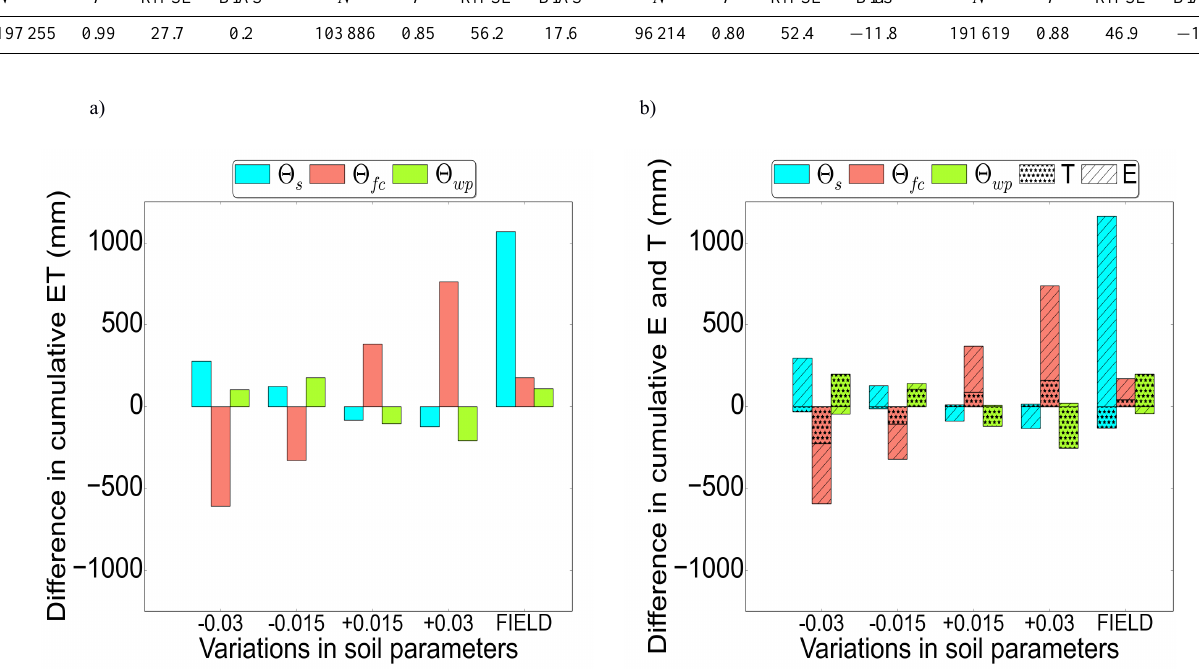
Figure 4. Sensitivity analysis: impact of variations in soil moisture at saturation ( θ s ), soil moisture at field capacity ( θ fc ) and soil moisture at wilting point ( θ wp ) on simulated (a) evapotranspiration (ET) and (b) soil evaporation ( E ) and plant transpiration ( T ), cumulated over the 12-year period. We display the difference in cumulative flux between the simulation PTF and the simulation PTF with modified soil parameters. FIELD means that the in situ values of the soil parameters (0.390, 0.310, 0.184 for θ s , θ fc , θ wp , respectively) are tested one by